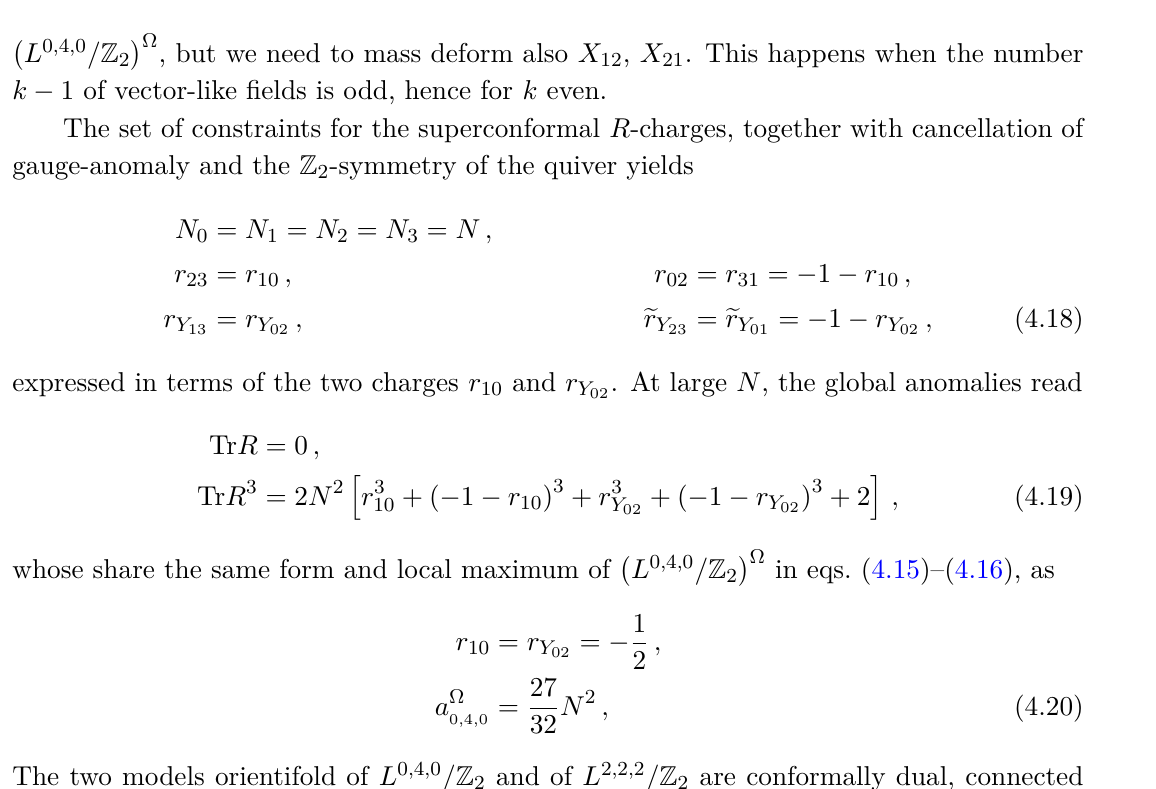
Figure 27. The model L 1 , 3 , 1 / Z 2 . On the left the toric diagram is drawn, at the center the five- brane and its orientifold projection with fixed points, on the right the quiver resulting from a choice of orientifold projection consistent with gauge anomalies. This does not belong to family A